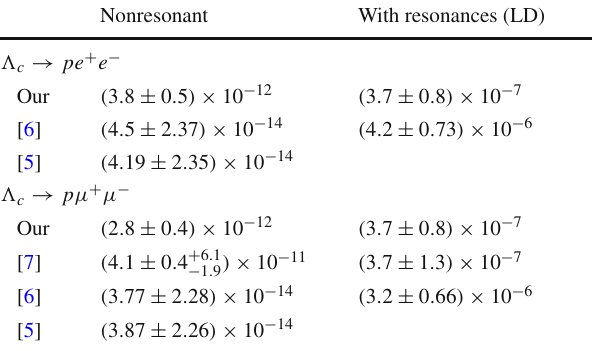
Table 4 Comparison of theoretical predictions for the (cid:2) c rare decay branching fractions Nonresonant With resonances